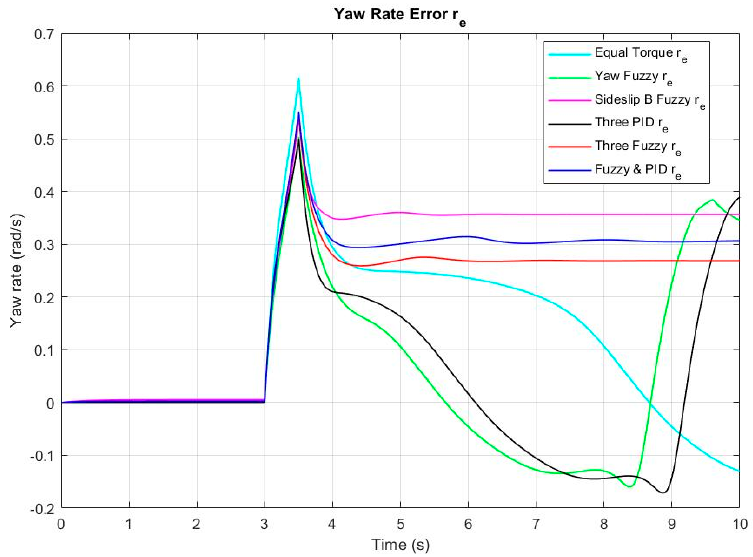
Figure 7. Yaw rate error response for the six control methods.